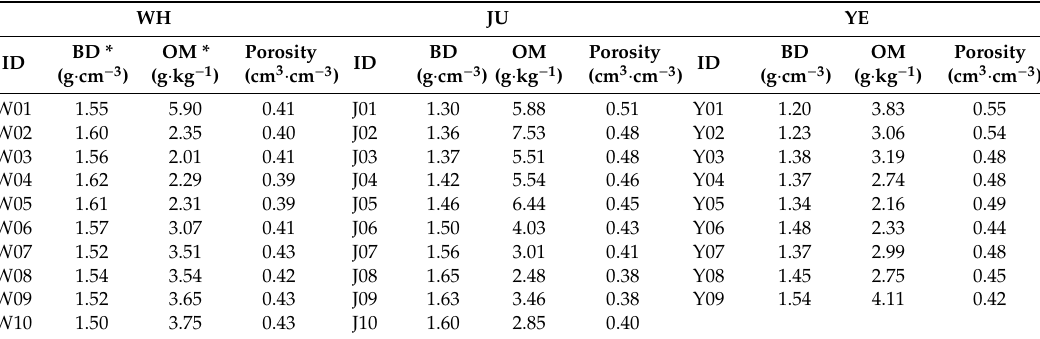
Table 1. Basic physical and chemical properties of plinthosol.